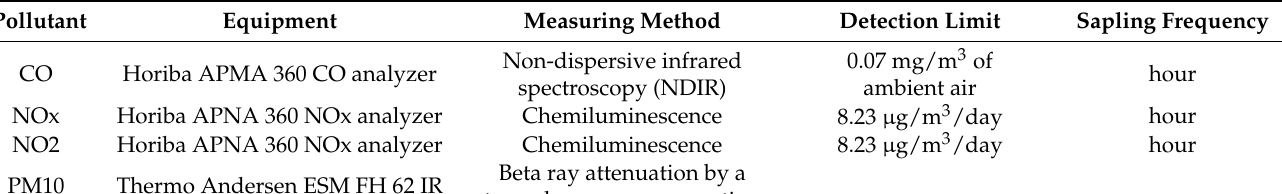
Table 1. Measuring equipment and techniques at stations.